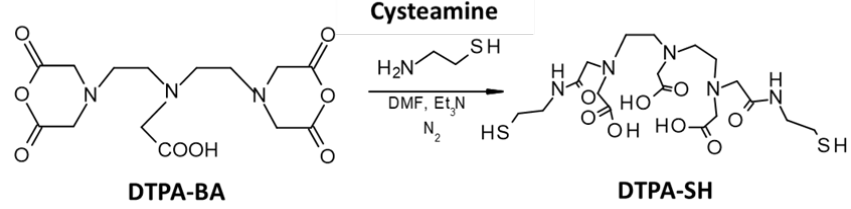
Figure 1. Thiolation reaction of DTPA.